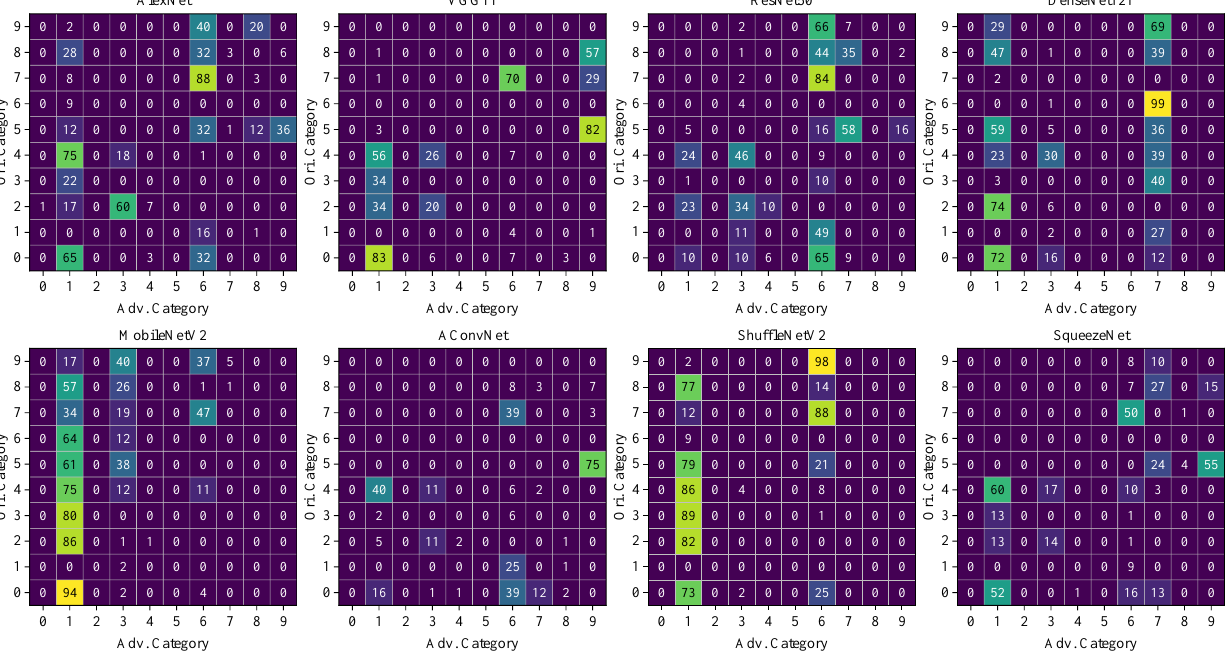
Figure A2. Distribution of adversarial labels. The attack is GD-UAP with VGG11 as substitute model. Ori. Category refers to the ground truth category of targets, Adv. Category denotes the misclassified category of the universal adversarial examples. The number from 0 to 9 respectively indicates the following classes: 2S1, BMP2, BRDM2, BTR70, BTR60, D7, T72, T62, ZIL131,